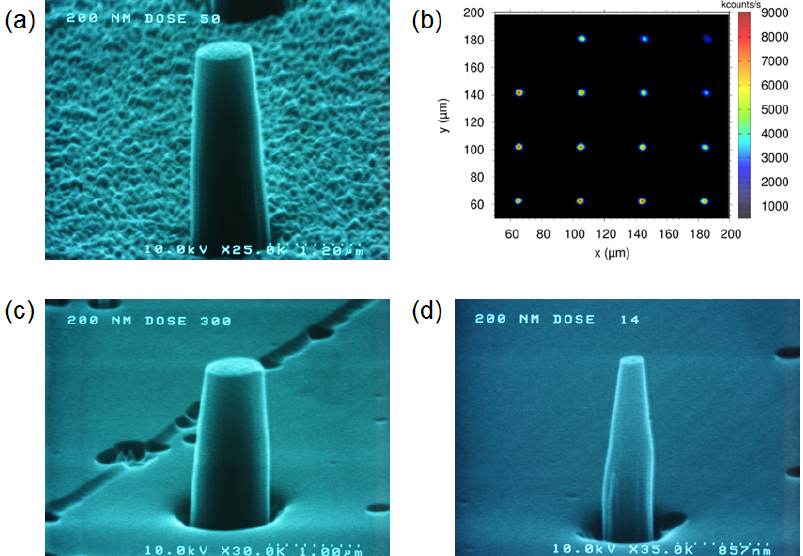
Figure 3. ( a ) SEM micrograph of a single pillar in the [100] diamond sample (2.1 mC/cm 2 , diameter approx. 720 nm). ( b ) Confocal microscopy image of the diamond nano-pillars, showing the fluorescence of NV centers. SEM micrographs of pillars in the [111] sample, written with different electron doses: ( c ) 12.6 mC/cm 2 , diameter approx. 600 nm, in pillar design round feature of 200 nm; ( d ) 588 μ C/cm 2 , diameter approx. 210 nm, in pillar design round feature of 200 nm.